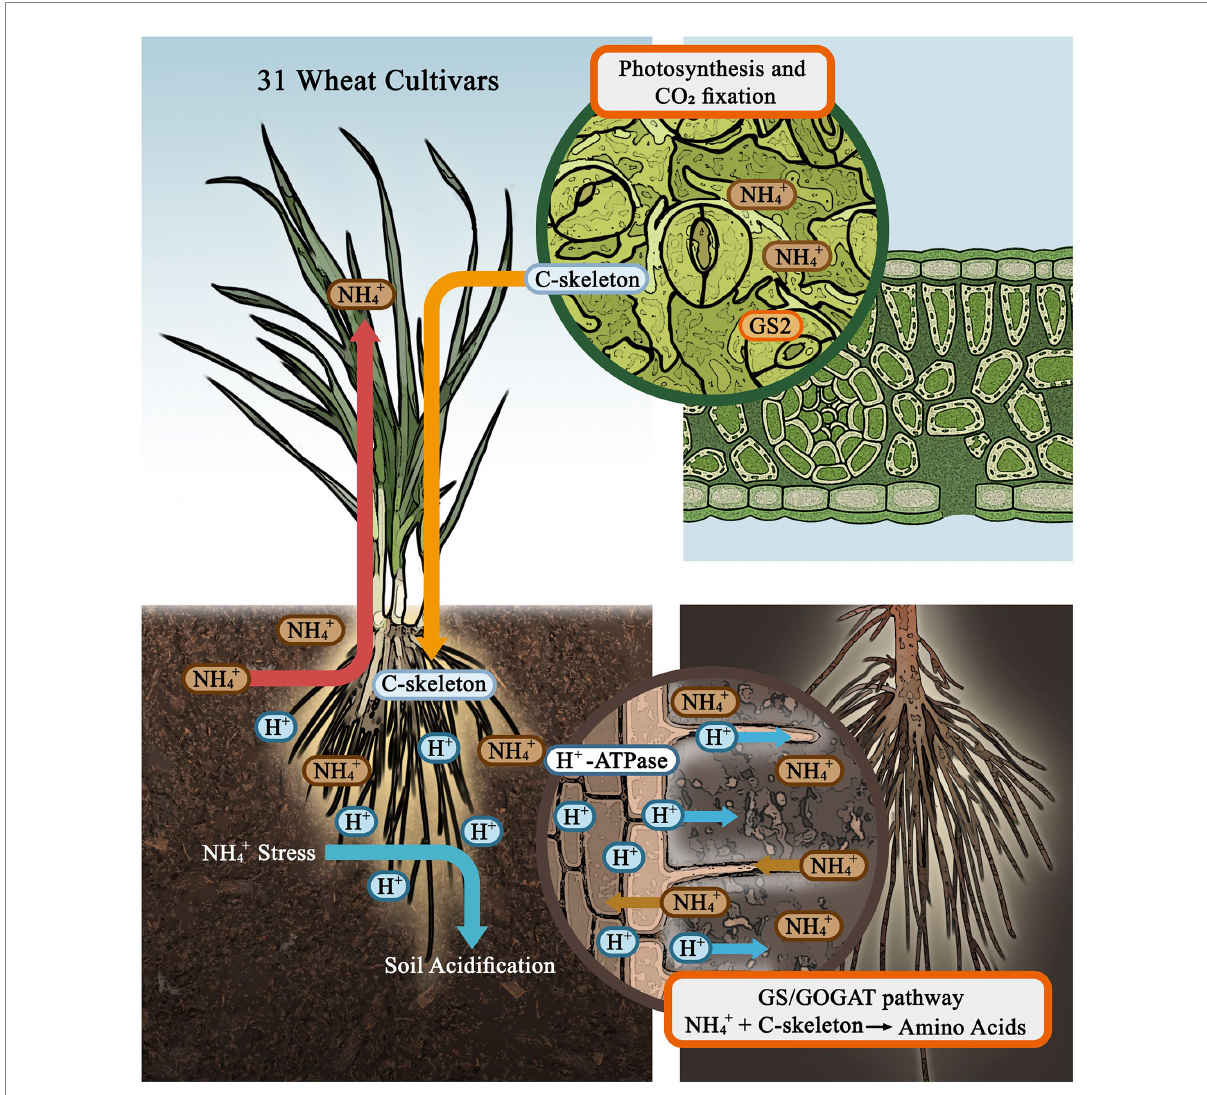
FIGURE 5 A proposed model of wheat physiological and biochemical responses to ammonium stress and soil